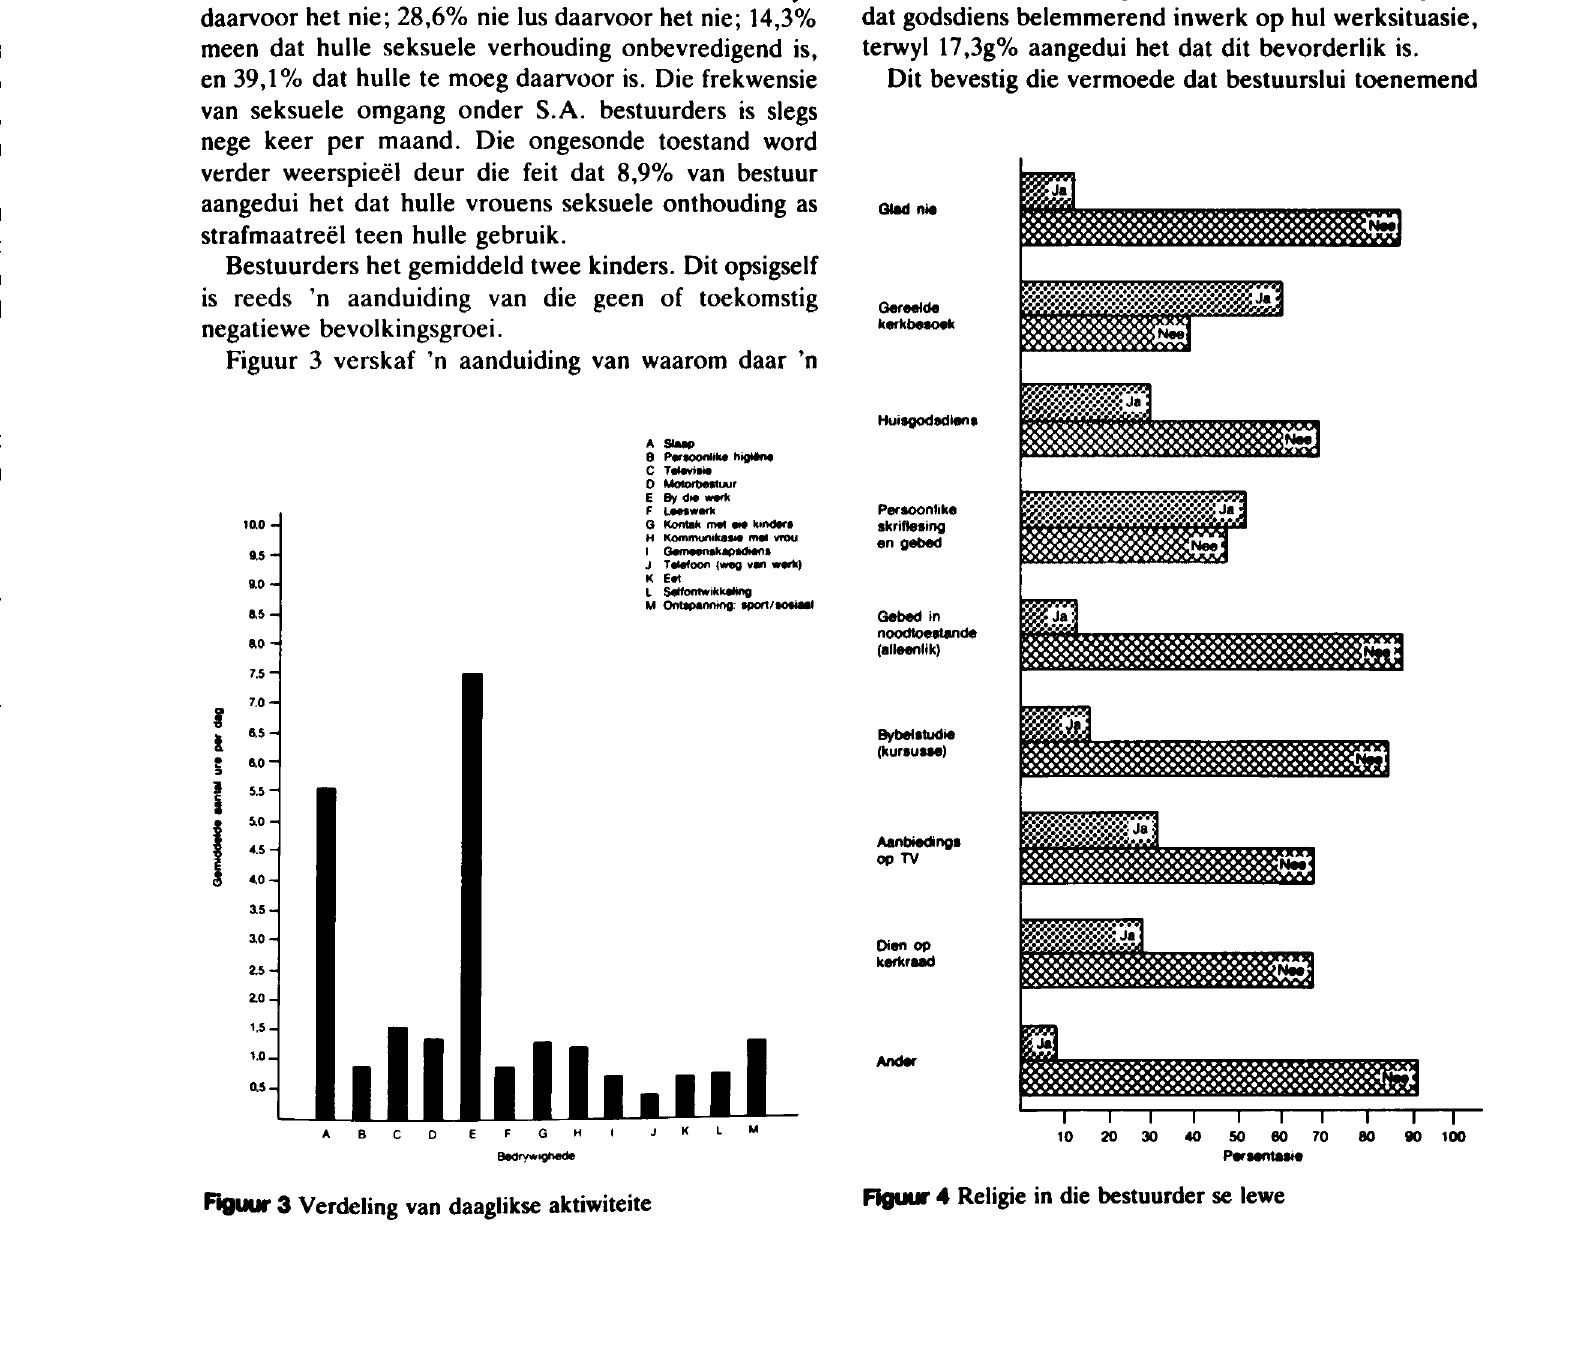
Figuur 3 verskaf 'n aanduiding van waarom daar 'n